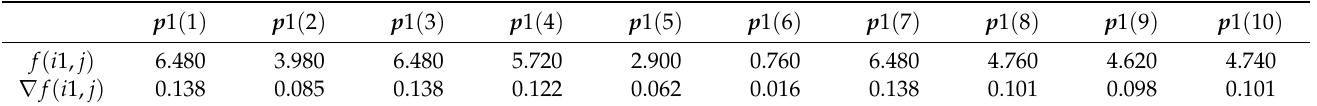
Table 4. The needs absolute weight f ( i 1, j ) and relative weight ∆ f ( i 1, j ) obtained from the once- visited water scenic spots.